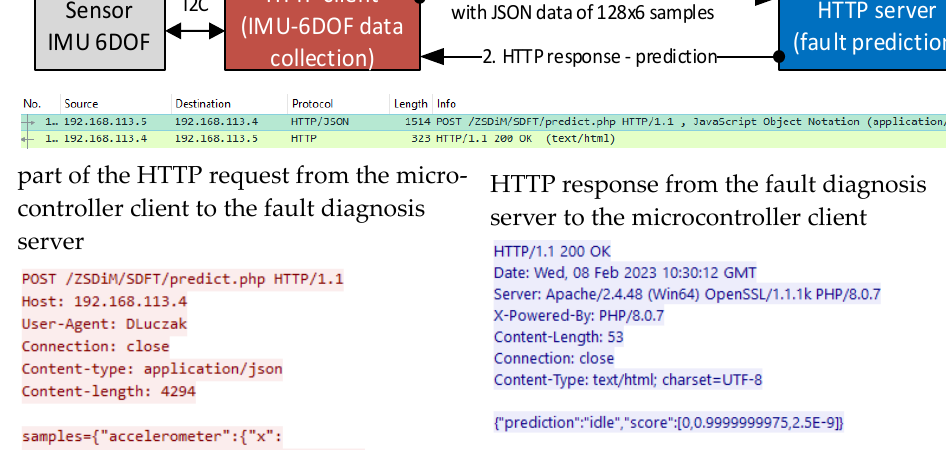
Figure 5. HTTP/1.1 request–response as batch processing of machine state prediction. Data from the application layer are encapsulated by lower layer headers. Figure 6 presents the encapsulation of HTTP/1.1 response from server to client. Data from HTTP/1.1 layer are put into the field payload of TCP and the header of TCP needs to be filled. The default TCP port is 80 for the HTTP/1.1 server.